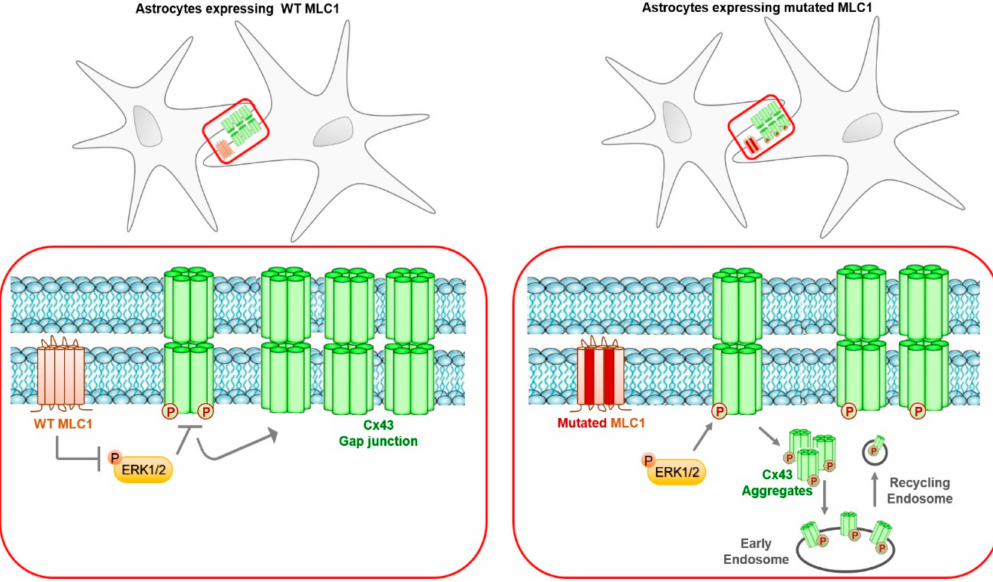
Figure 9. Schematic representation of the possible mechanism of the MLC1-mediated Cx43 regulation in astrocytes.